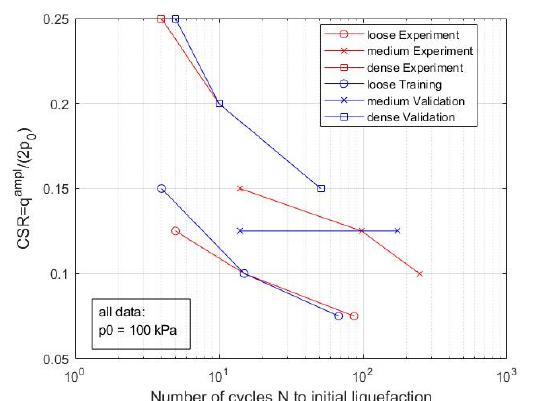
Fig. 7 Amplitude-pressure ratio q ampl /(2 p 0 ) vs. the number of cycles N required to reach the onset of large axial strain generation (| ε 1 | > 1 %), ( I D0 = 0.24-0.87 and p 0 =100-400